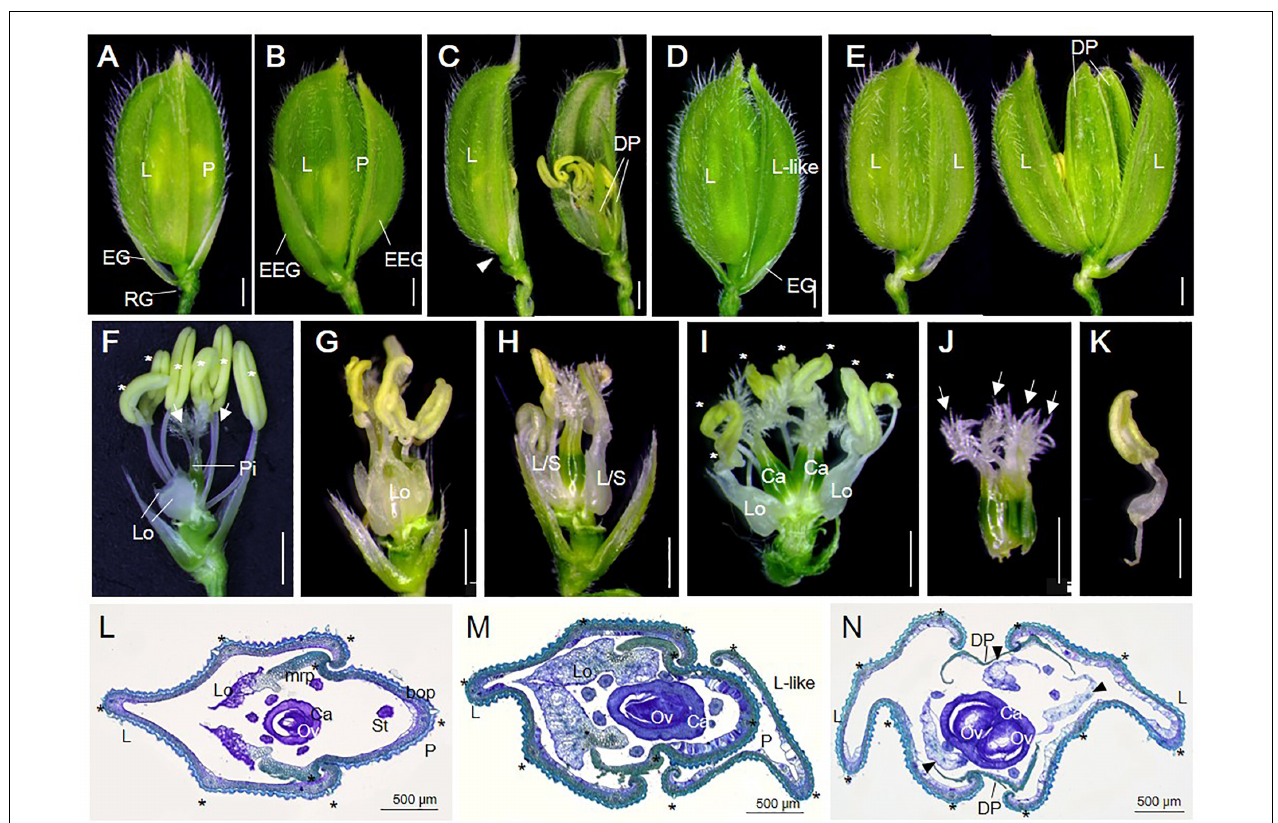
FIGURE 1 | Spikelet phenotypes of WT and osvil 2 mutant. (A–E) Phenotypes of WT and osvil2-1 spikelets. (A) WT spikelet with pair of rudimentary glumes and empty glumes, lemma, palea. (B) osvil2-1 spikelet with elongated empty glumes. (C) osvil2-1 spikelet with degenerated palea and no empty glume on lemma side (arrowhead). (D) osvil2-1 spikelet with additional lemma-like organ. (E) osvil2-1 spikelet with 2 lemma and 2 degenerated palea. (F–K) Phenotypes of inner floral organs of WT and osvil2-1 . Palea and lemma were removed. (F) WT spikelet comprises two lodicules on lemma side, six stamens (asterisks), and one pistil with two stigmas (arrows). (G) osvil2-1 floret with extra lodicules and immature stamens. (H) osvil2-1 floret with lodicule–stamen mosaic organs. (I) osvil2-1 floret with extra lodicules, seven stamens (asterisks), and two carpels. (J) osvil2-1 carpel in which several carpels are fused. Number of stigma is also increased (arrows). (K) Lodicule–stamen mosaic organ in osvil2-1 . (L) Cross section of WT spikelet. (M,N) Cross section of osvil2 spikelet. (M) Formation of additional lemma-like organ in osvil2 spikelet. (N) osvil2 with two lemma, two degenerated palea, three abnormal lodicules (arrow heads), and one fused carpel having two ovules. bop, body of palea; Ca, carpel; DP, depressed palea; EG, empty glume; EEG, elongated empty glume; L, lemma; Lo, lodicule; L/S, lodicule–stamen mosaic organ; L-like; lemma-like organ; mrp, marginal region of palea; Ov, ovule; P, palea; RG, rudimentary glume. Asterisks indicate stamens (F,I) or vascular bundles (L–N) . Scale bars = 1 mm (A–K) or 500 µ m (L–N)